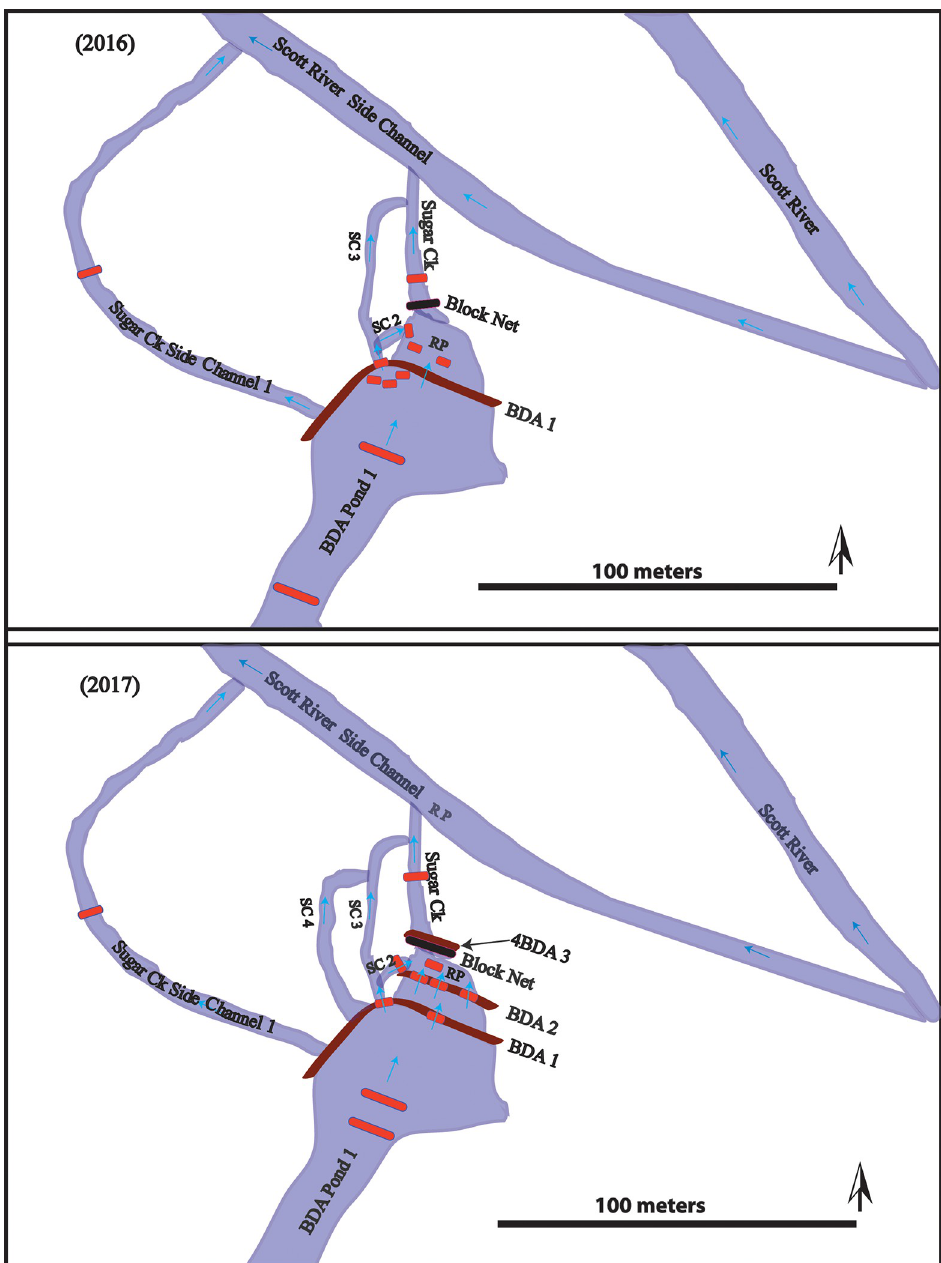
Fig 2. Planview of fish passage experimental setups in 2016 and 2017. The short red lines around BDAs indicate temporary PIT antennas, the long red lines indicate permanent PIT antennas; SC = side channel; RP = Release Pool, where tagged fish were released; BDA = Beaver Dam Analogue. Major flow paths are shown with blue arrows, though many minor flow paths exist throughout and between the BDAs. Blue shaded areas are places of BDA-influenced